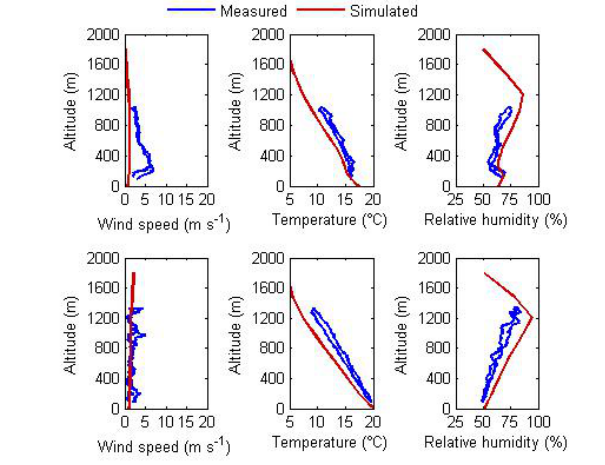
Figure 5. Measured and simulated vertical profiles of the atmosphere; morning profile No. 8 (upper plates) and noon profile No. 9 (lower plates). See Table 2 for